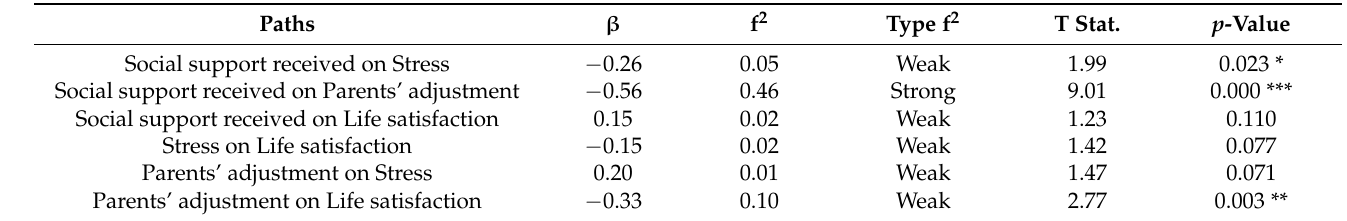
Table 3. Path coefficient, effect size, magnitude, and significance of the structural social support received model paths.